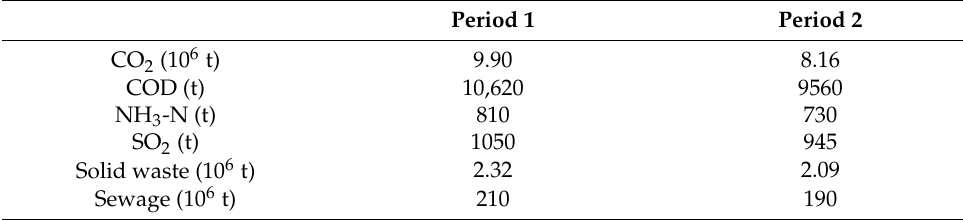
Table 2. Input parameters related to emission threshold.